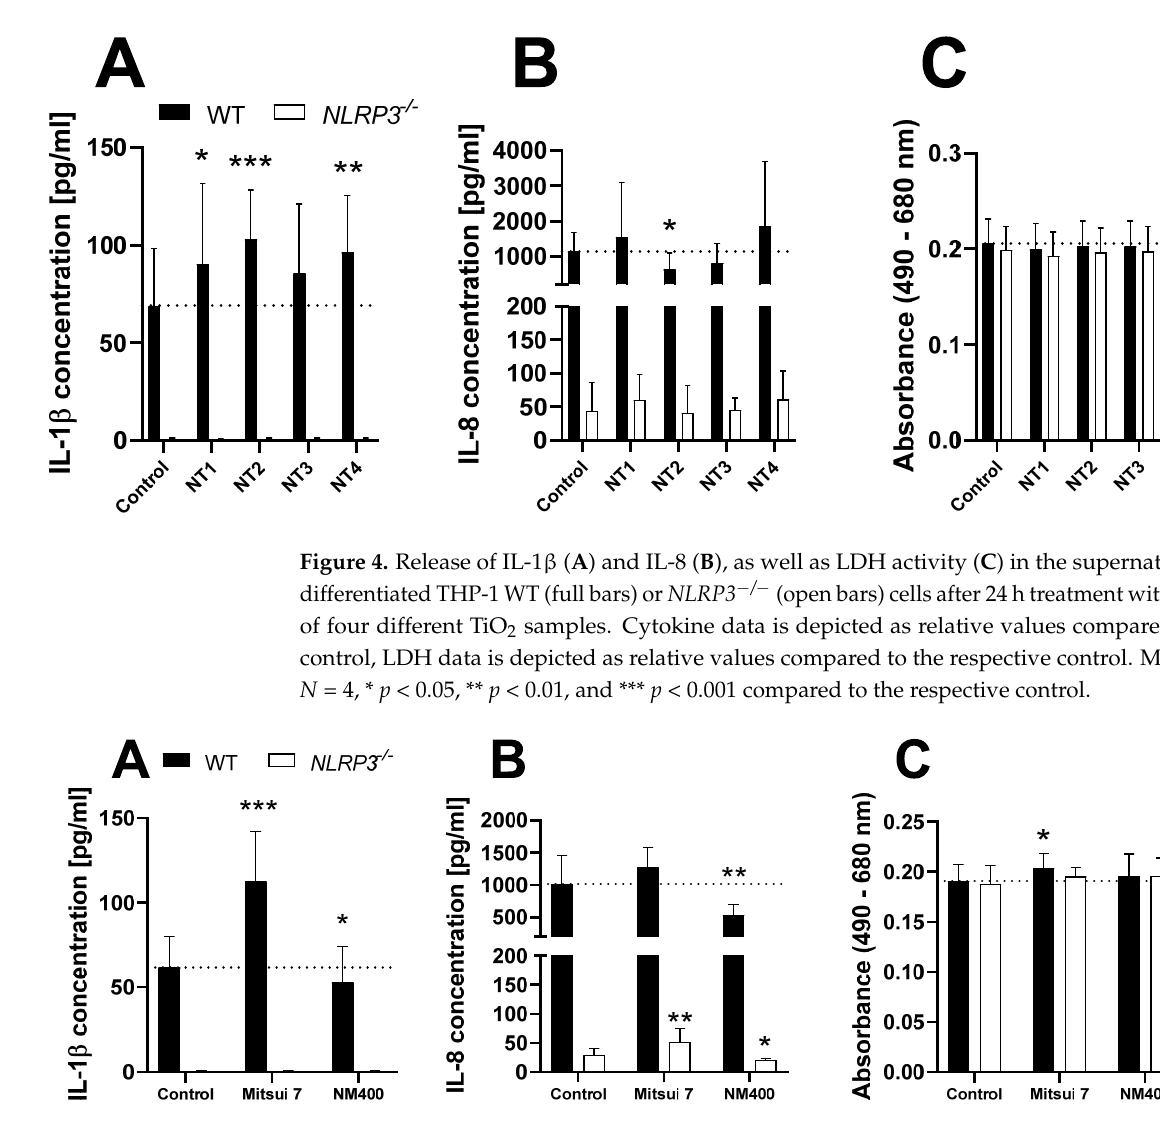
Figure 6. Release of IL-1 β ( A ) and IL-8 ( B ), as well as LDH activity ( C ) in the supernatant of PMA- differentiated THP-1 WT (full bars) or NLRP3 − / − (open bars) cells after 24 h treatment with 50 µg/cm 2 of different plastic particles. Cytokine data is depicted as relative values compared to the WT con- trol, LDH data is depicted as relative values compared to the respective control. Mean ± SD of N = 4, * p < 0.05 and *** p < 0.001 compared to the respective control. Within this group of plastic samples, only PS-NH 2 induced a significant increase in IL-1 β secretion in WT cells, accompanied by a strong cytotoxic effect as indicated by an increased release of LDH into the supernatant. The cytotoxic effect was also present in the NLRP3 − / − cells, while no effect on IL-1 β release was observed. Furthermore, the secretion of IL-8 was significantly reduced after PS-NH 2 treatment of the WT cells. PET, PAN, and